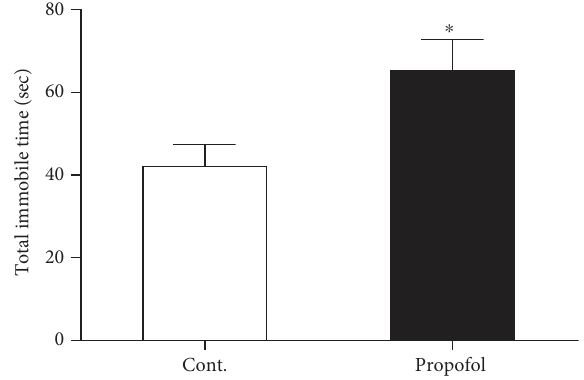
Figure 2: Propofol increased the total immobile time of mice compared to control mice in the forced swimming test. All data are expressed as the means ± SEM . n = 10 . ∗ p < 0 05